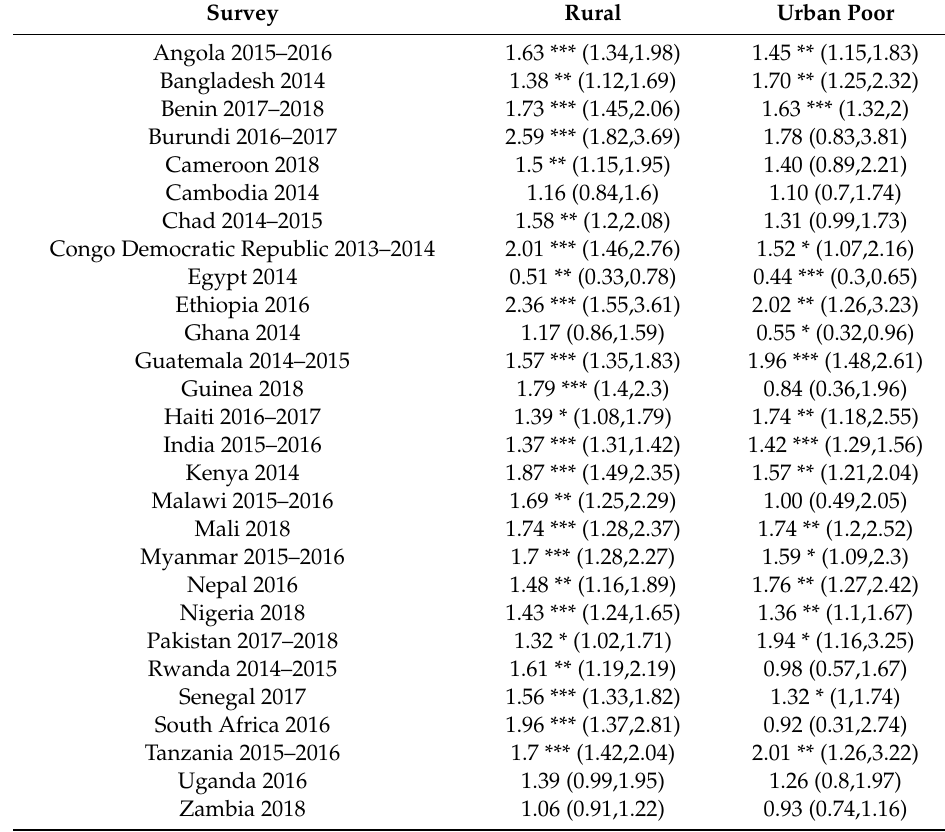
Table A1. Adjusted odds ratios of stunting of children living in urban poor and rural clusters compared to children living in urban non-poor